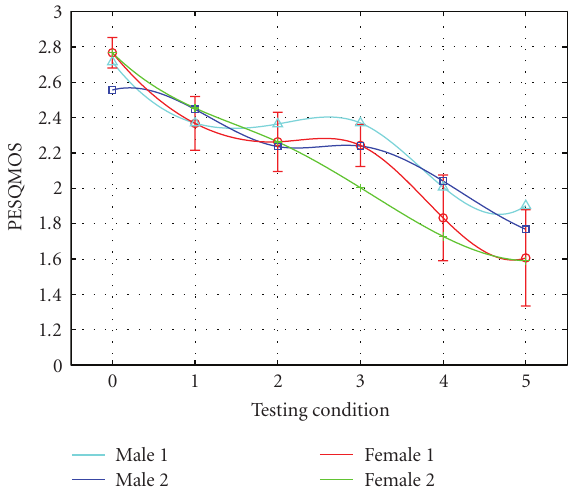
Figure 9: Impact of background tra ffi c on packet loss in VoWLAN connections. Other detailed descriptions of Figure 7 apply appro- priately.